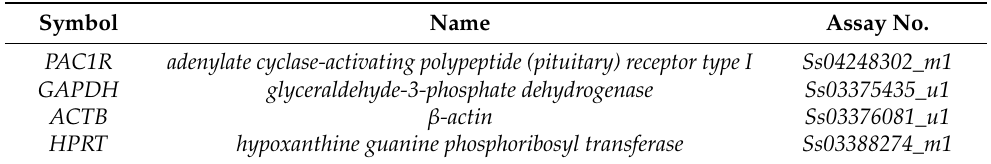
Table 1. TaqMan assays used in the